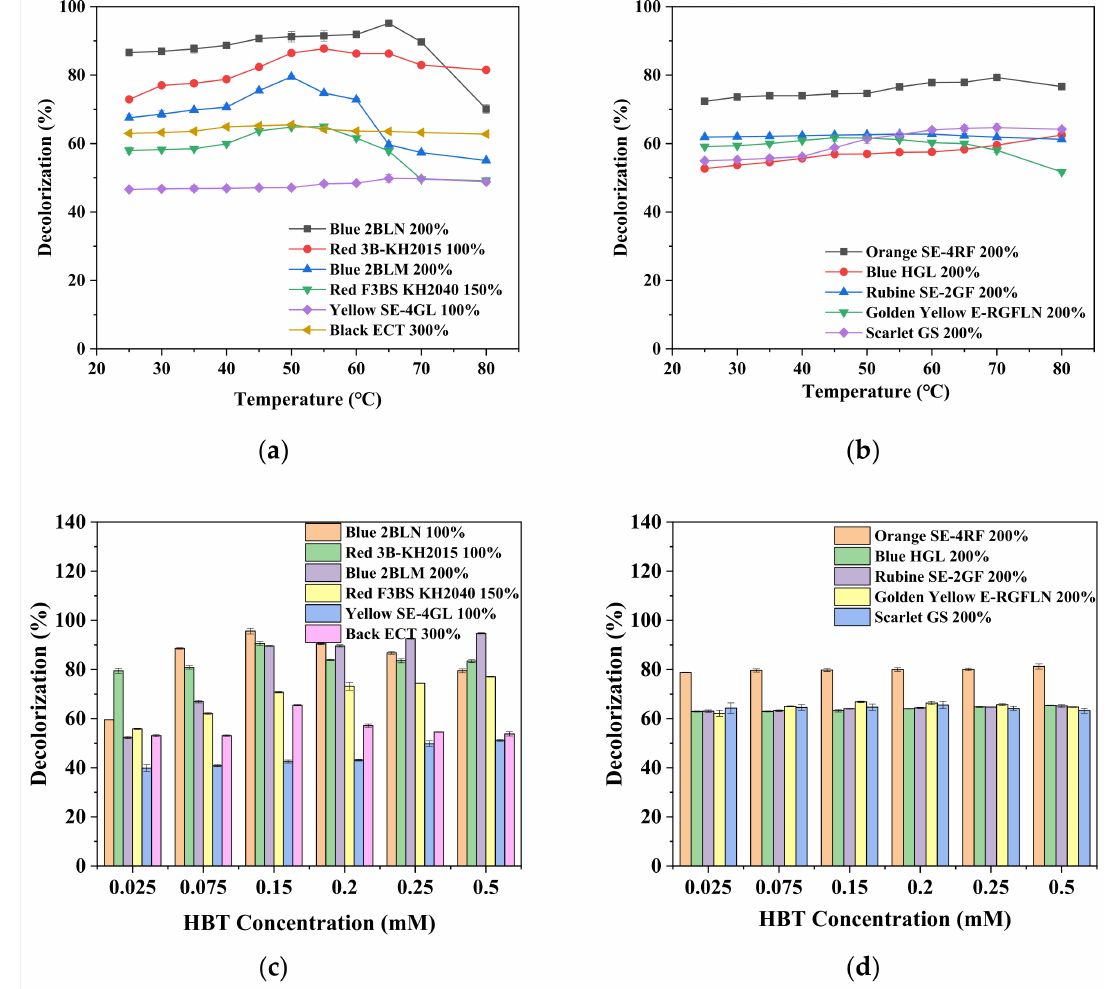
Figure 4. Effect of temperature ( a , b ) and HBT dosage (0.025~0.5 mM) ( c , d ) on decolorization rate of 11 synthetic dyes with other parameters at optimal conditions, as listed in Table